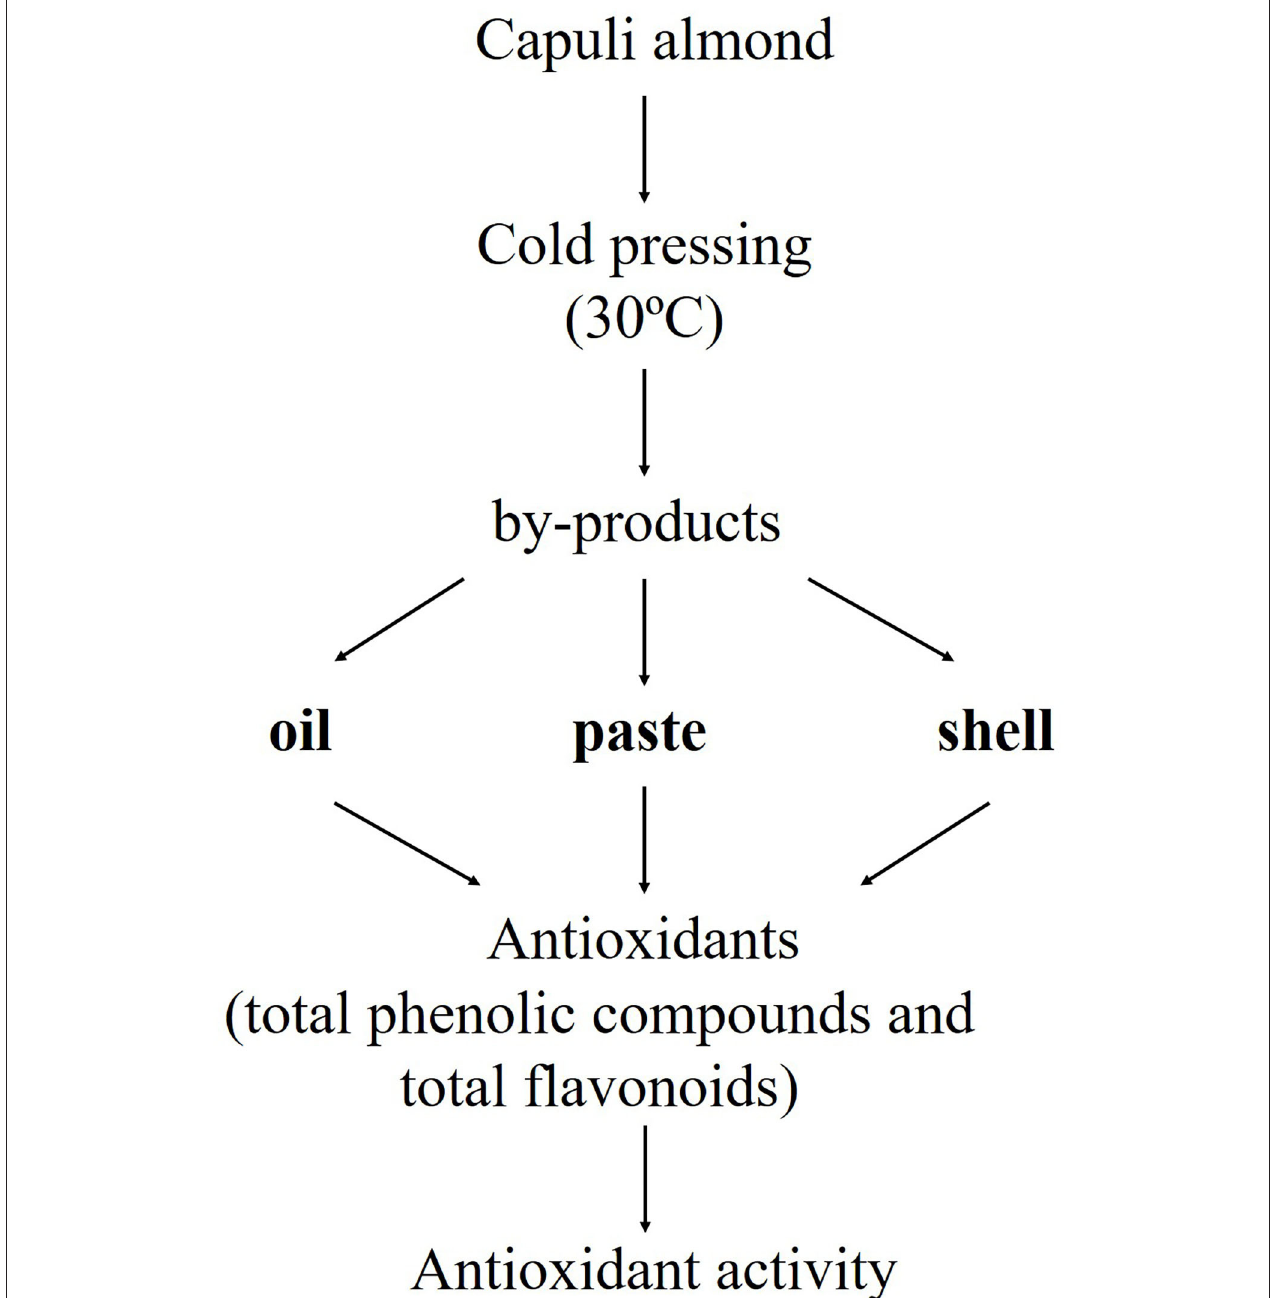
FIGURE 1 | Process of valorization of the Prunus serotina (var. capuli )